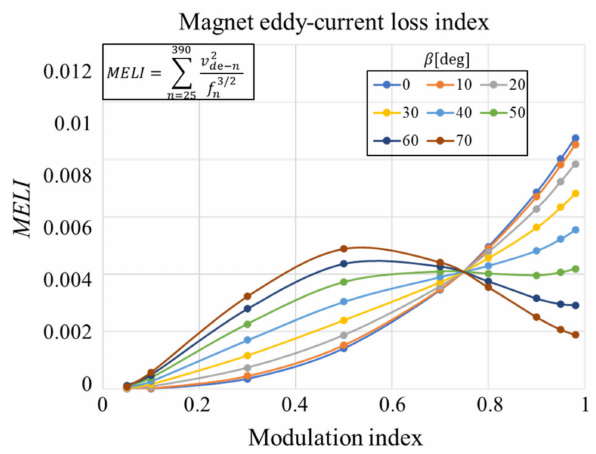
Figure 7. Variation of magnet eddy current index with modulation index of the 25th–390th harmonics when the switching and fundamental frequencies are 10 kHz and 200 Hz,